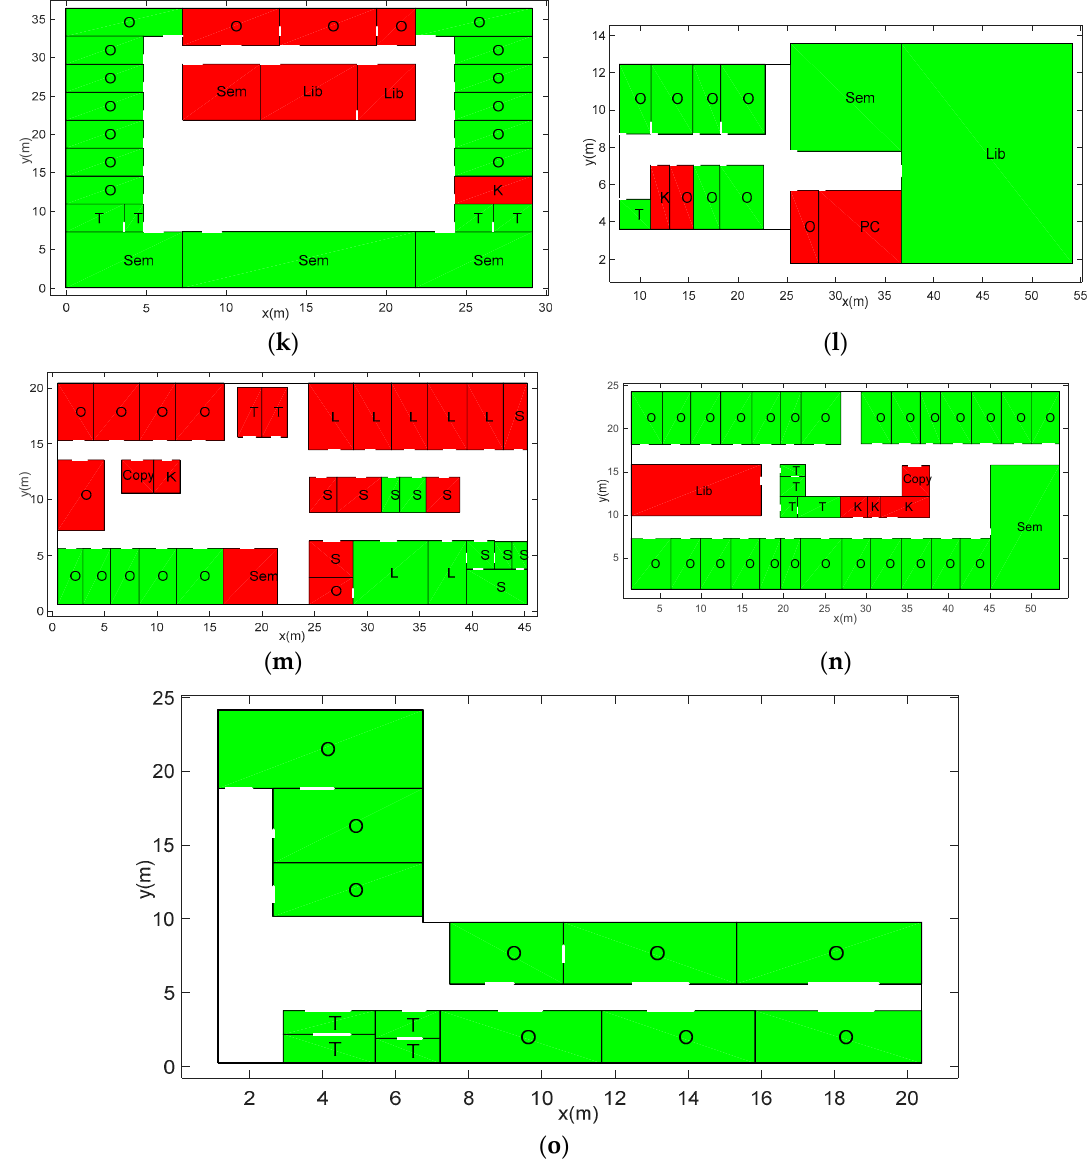
Figure 11. Floor plans ( a–o ) used for test.